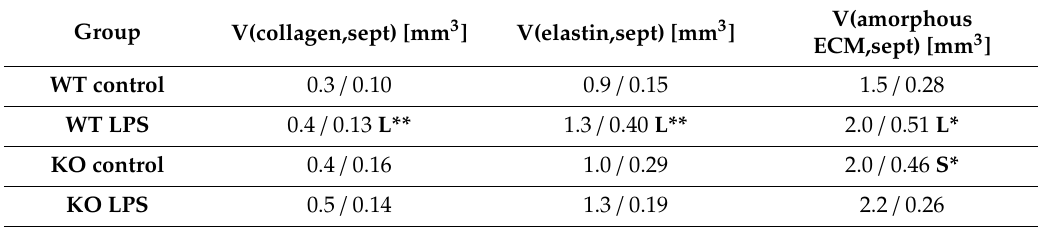
Table 1. Septal extracellular matrix (ECM) composition in the left lung lobe. Septal ECM compositions were ultrastructurally quantified as either collagen fibrils (V(collagen,sept)), elastic fibers (V(elastin,sept)), or other amorphous ECM (V(amorphous ECM,sept)). The results are displayed as mean / SD. L = significant lipopolysaccharide (LPS) e ff ect in the respective strain group, S = significant strain e ff ect in respective exposure group; * p < 0.05, ** p < 0.01.